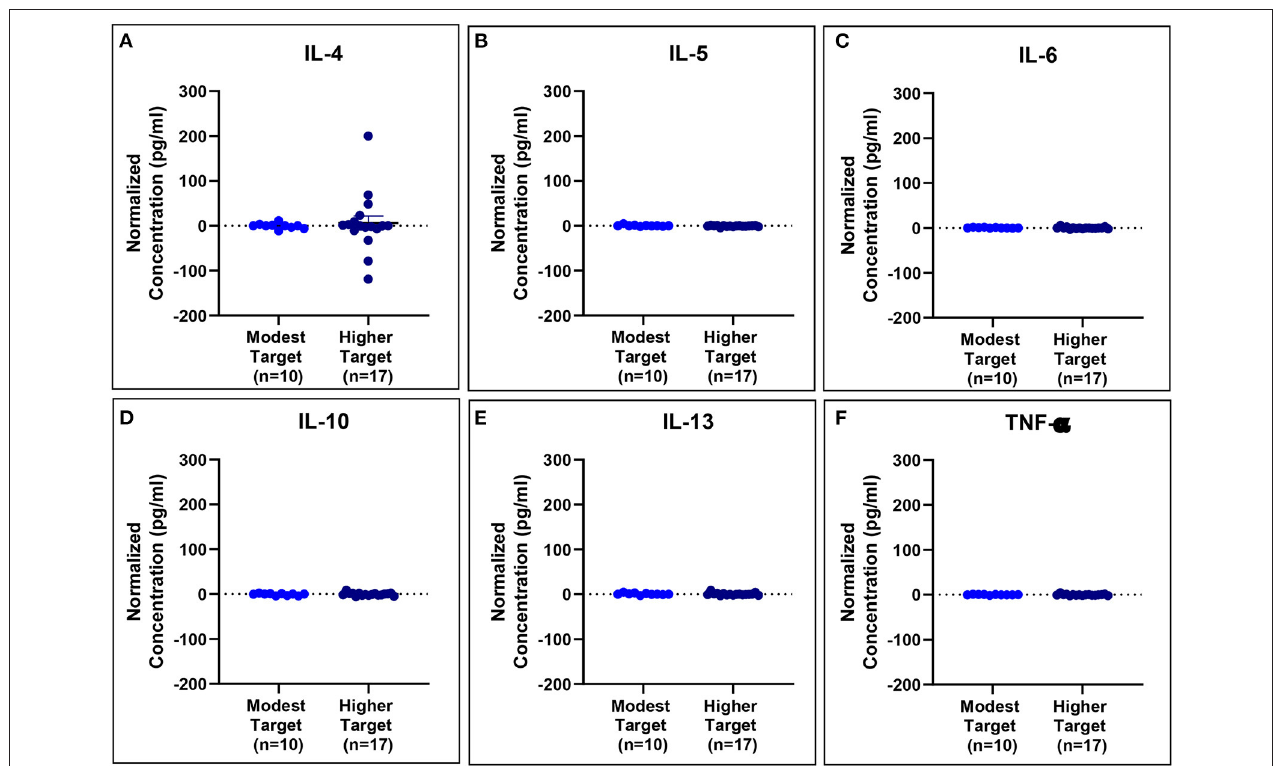
FIGURE 11 | Serum cytokine concentrations normalized to baseline are comparable for modest and higher target allergics. No significant differences were observed in IL-4 (A) , IL-5 (B) , IL-6 (C) , IL-10 (D) , IL-13 (E) , and TNF- α (F) concentrations normalized to baseline in the peripheral blood post-exposure for allergics exposed to a higher vs. modest HDM